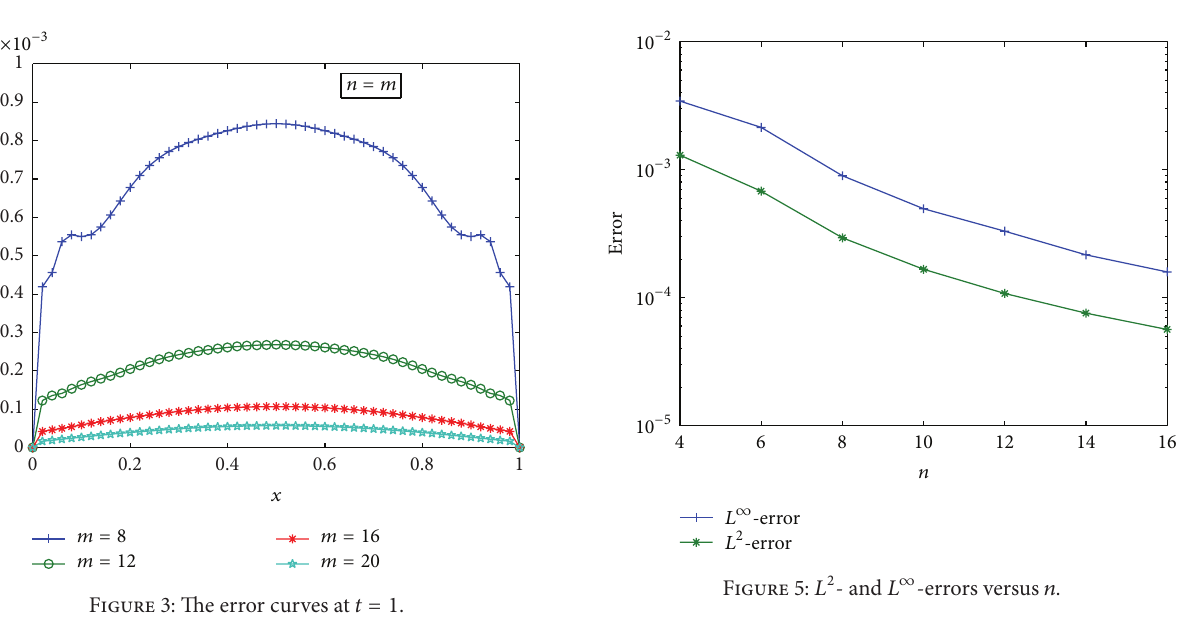
Figure 3: The error curves at 𝑡 = 1 .